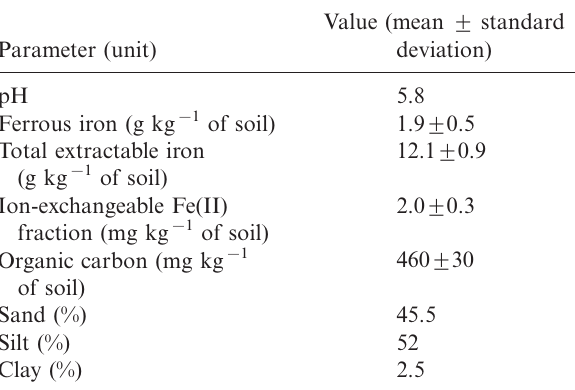
Table 1. Soil properties